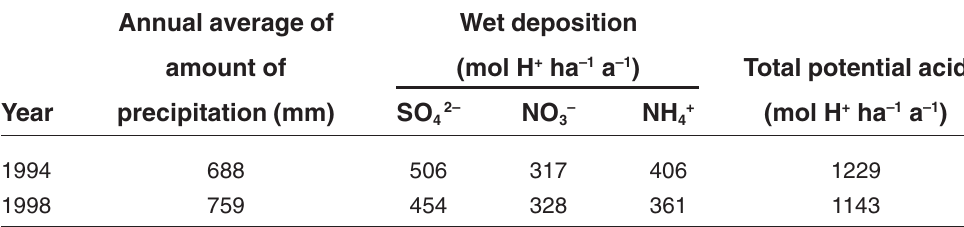
Annual Averages of Amount of Precipitation, Wet Depositions of Sulphur and Nitrogen Compounds (SO 42– , NO 3– , and NH 4+ ), and Total Potential Acid in the Czech Republic in 1994 and 1998 (mol H + ha –1 a –1